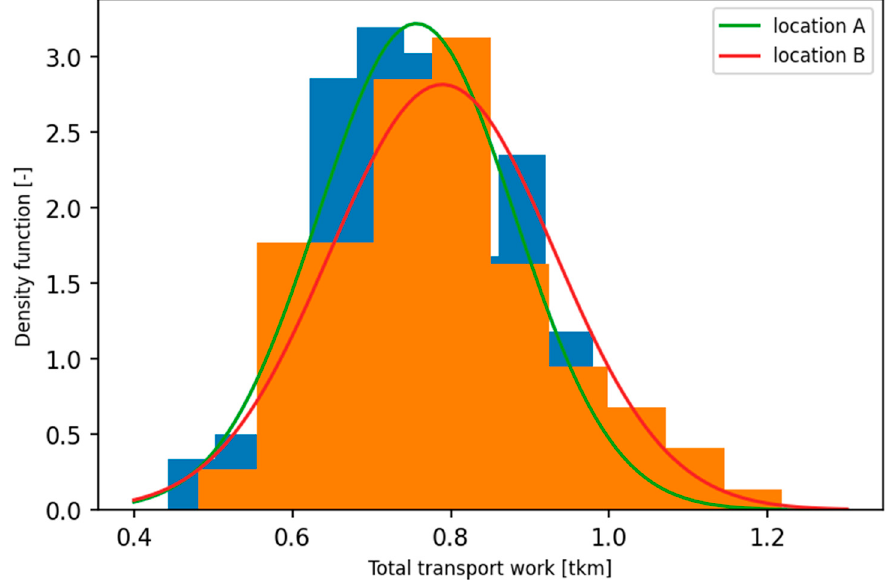
Figure 3. Distributions of the total transport work for the considered alternative hub locations in the synthetic network.